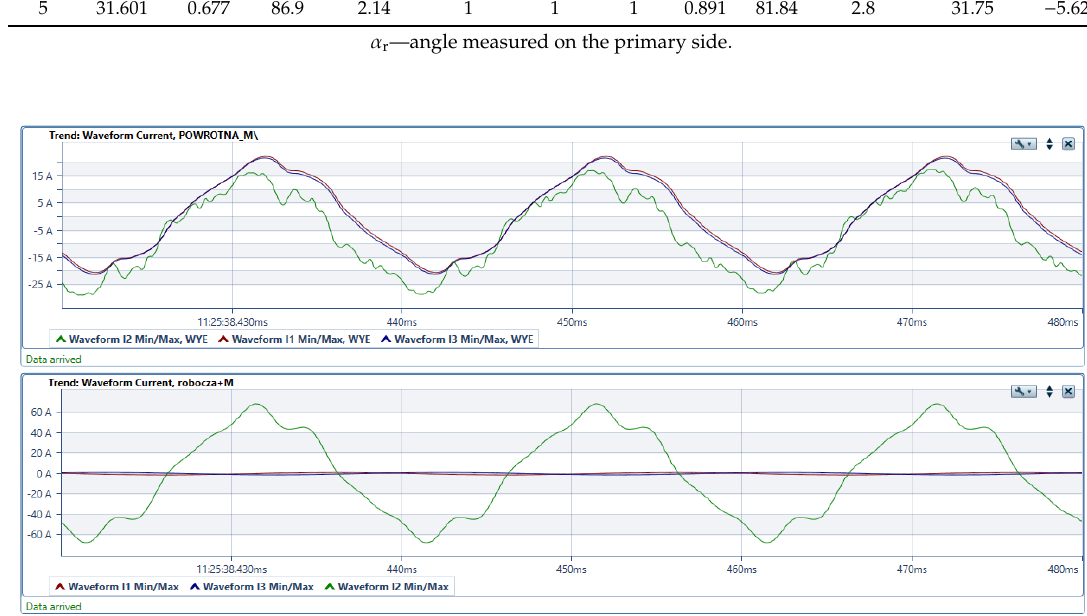
Figure 18. Fault between cable screen and core (nr 1 in Table 2) of 2 points bonded cable. Table 2. Results of network tests.